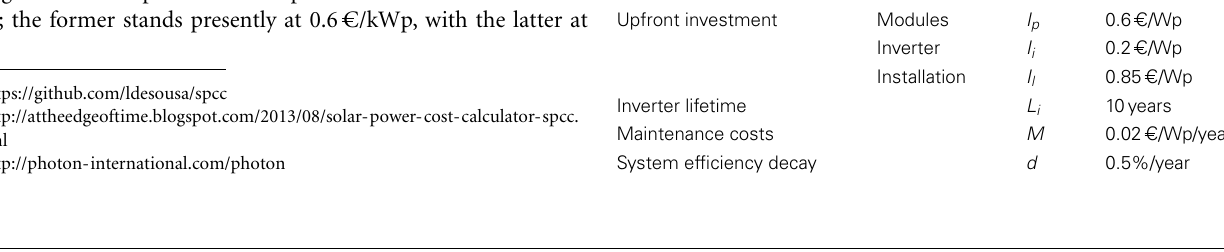
Table 1 | Parameters used to compute basic PV electricity costs. Upfront